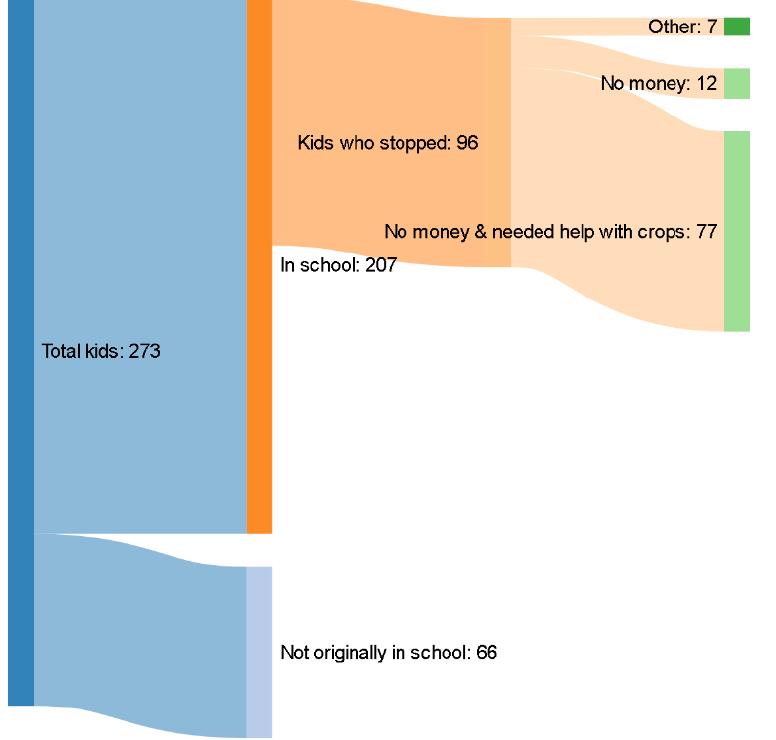
Figure 1. Survey results from parents of children at the institution Mixte du Progres in Dessab in 2016.